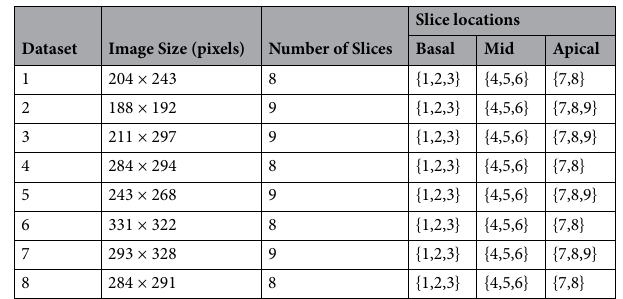
Table 10. Description of the 2D multi-slice cardiac cine MRI datasets used in the experimental validation. For each dataset, the image size of a single slice, number of slices in that dataset, and the slice locations relative to basal, mid-ventricular, and apical sections are provided.